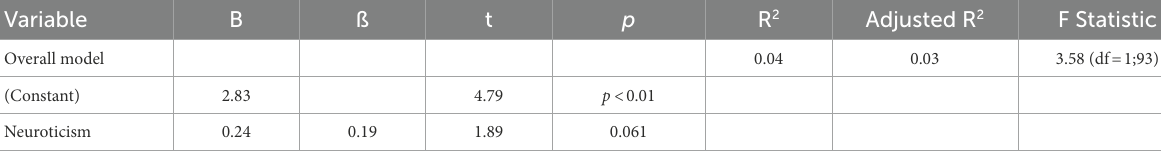
TABLE 6 Regression analysis summary for agreeableness predicting person-organization